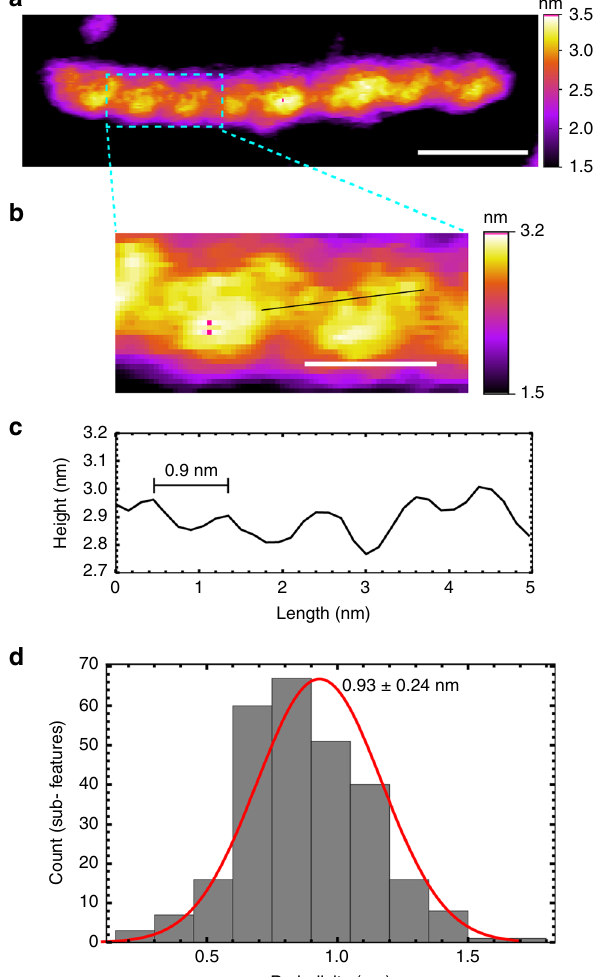
Fig. 6 Observation of 0.9 nm periodicity. a AFM image of a Type I G-wire. The length scale (white bar) is 10 nm. b A zoomed portion of the above image revealing periodic right-handed sub-features. The length scale (white bar) is 4 nm. c The height pro fi le from the selected section. d Periodicity histogram from 88 sections of 51 Type I G-wires revealed peak-to-peak distance of 0.93 ± 0.24